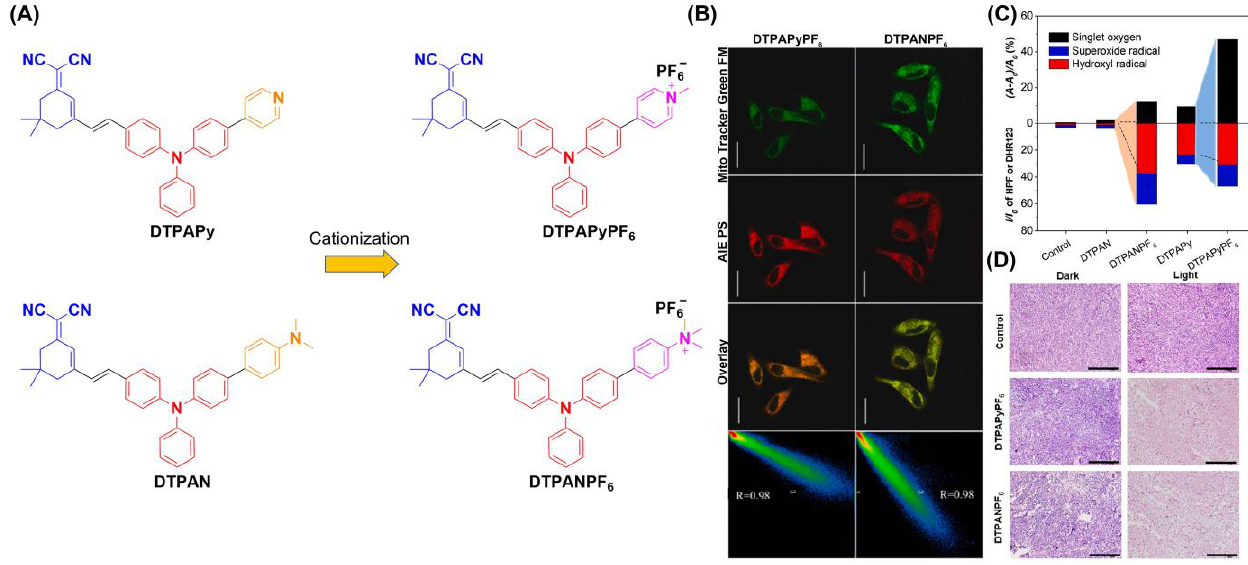
Figure 9. ( A ) Structure of DTPAN, DTPAPy, DTPANPF 6 and DTPAPyPF 6 ; ( B ) co-localization of HeLa cells incubated with DTPANPF 6 or DTPAPyPF 6 ; ( C ) summary of different ROS generation of DTPAN, DTPAPy, DTPANPF 6 and DTPAPyPF 6 ; ( D ) H&E staining of tumor tissues. Reprinted with permission from Ref [78]. Copyright 2022 Elsevier Ltd.